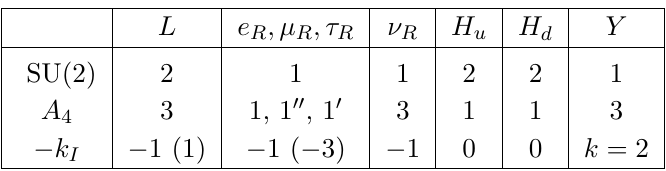
Table 1 . The charge assignment of SU(2), A 4 , and the modular weight ( (cid:0) k I for (cid:12)elds and k for coupling Y ) in the type I seesaw model. The right-handed charged leptons are assigned three A 4 singlets, respectively. Values of (cid:0) k I in the parentheses are alternative assignments of the modular